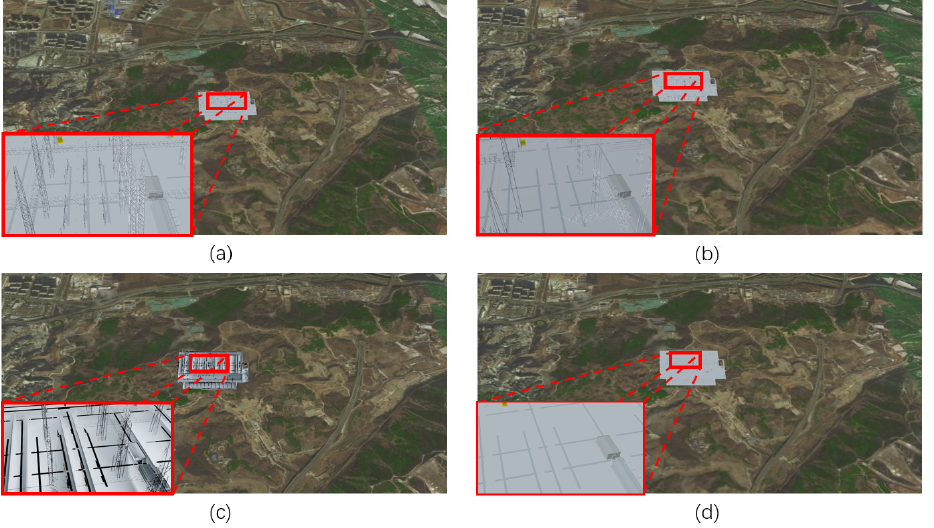
Figure 8. Model visualization at a viewing distance of 1500 m when using: ( a ) proposed method, ( b ) Method 1, ( c ) Method 2, and ( d ) Method 3.